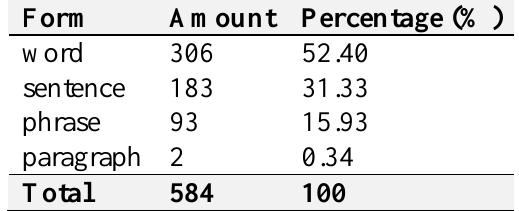
Tabel 1. Amount of scribbling language preferences on